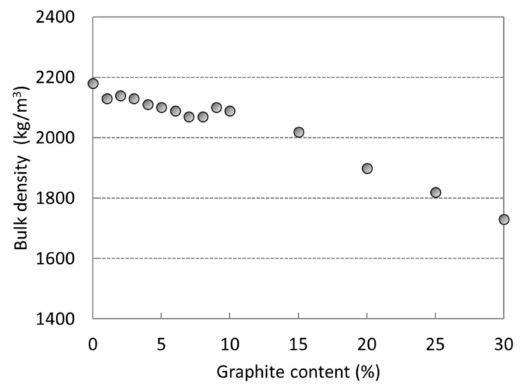
Figure 5. Bulk density of AAS composites with 0 wt%–30 wt% of graphite